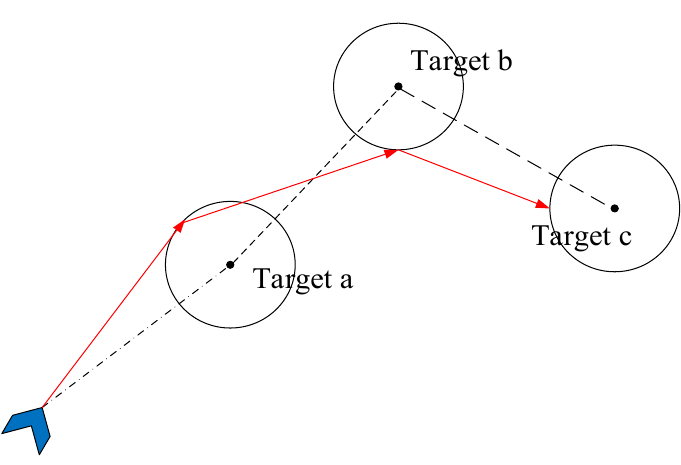
Figure 3. The optimal path of UAV carrying S ‐ 1 sensor.